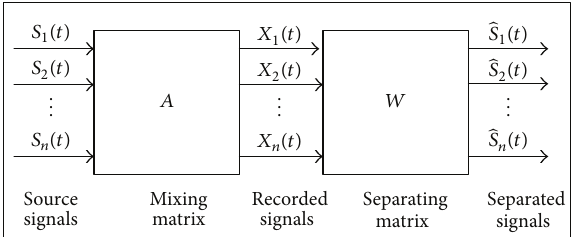
Figure 5: ICA block diagram.